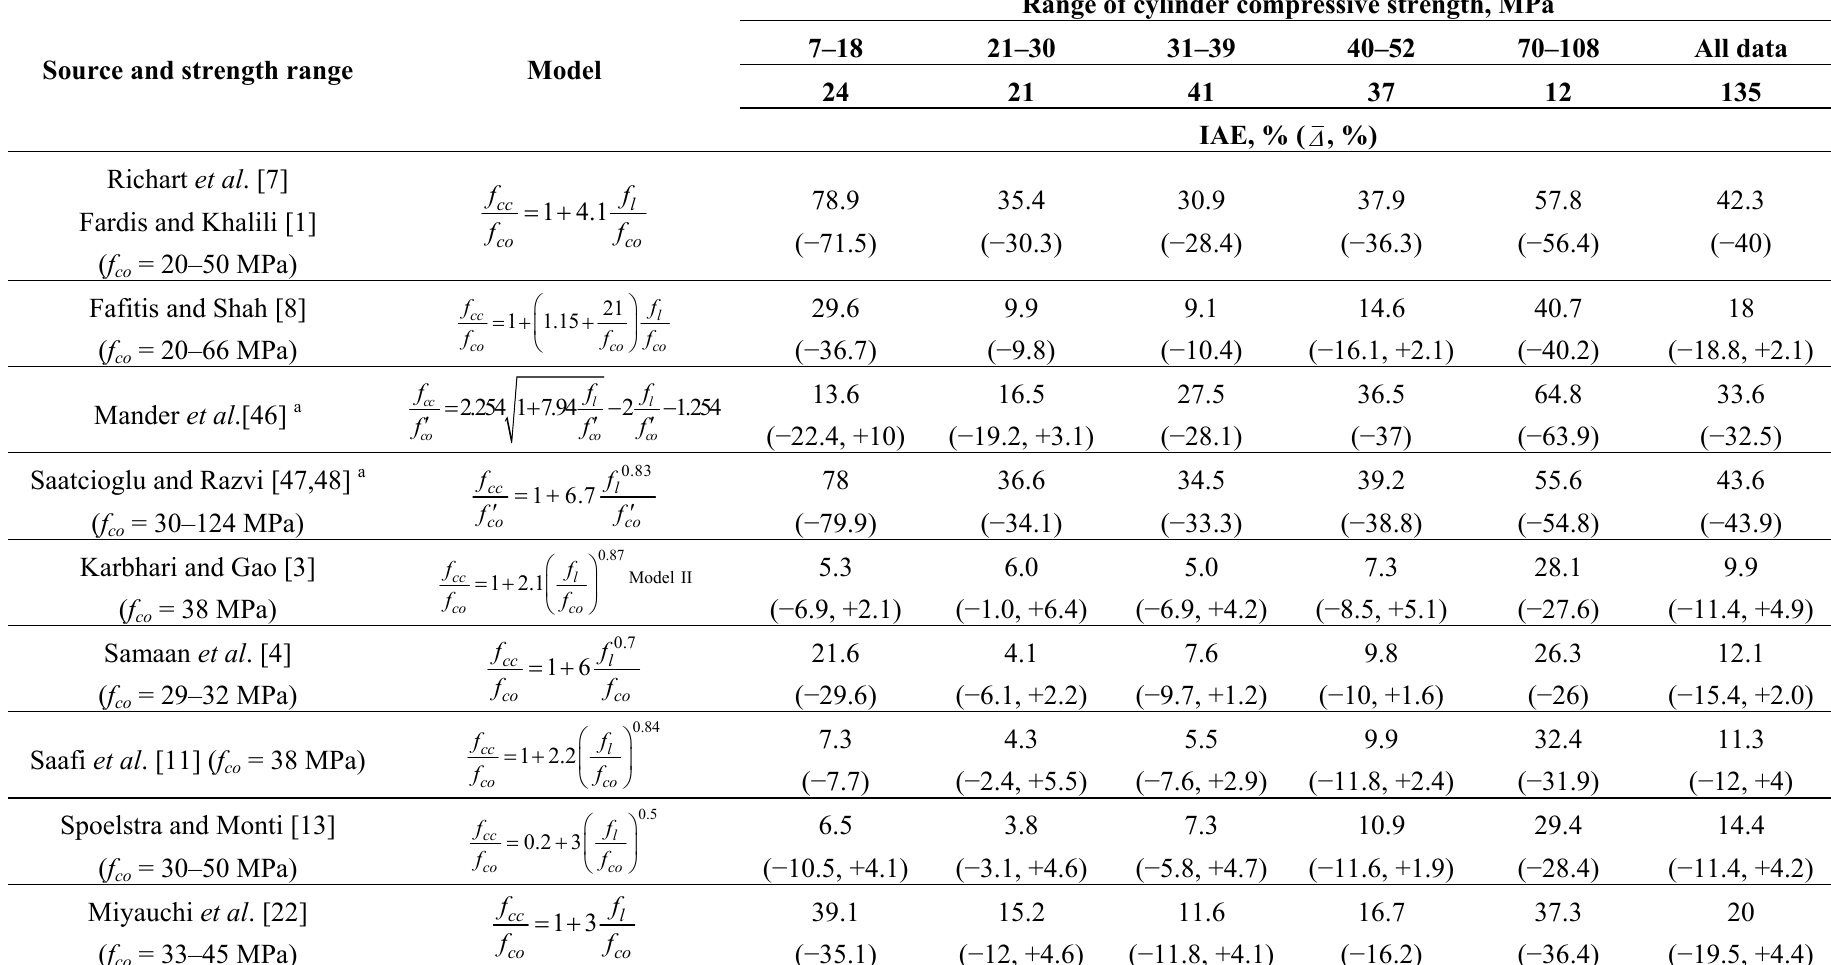
Table 3. Prediction of ultimate compressive strength in FRP-confined